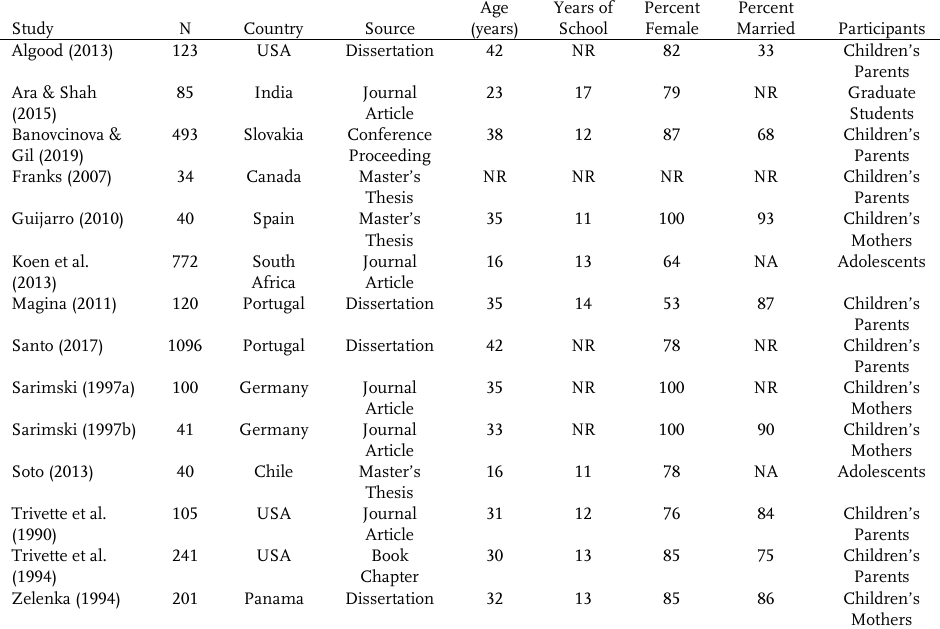
Table 3 : Selected characteristics of the studies and study participants Study